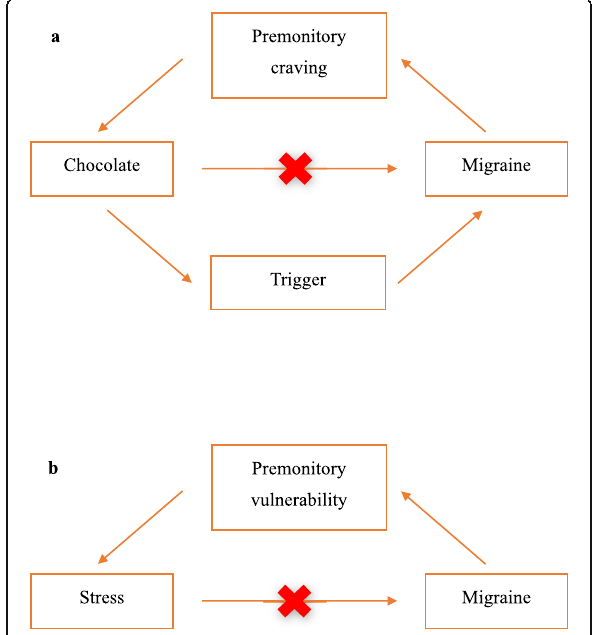
Fig. 2 Directed acyclic graphs illustrating the causality between attack risk factors and migraine attacks. a) Recall the experiment evaluating if chocolate is a migraine trigger, or rather the case of reverse causality where the premonitory craving of an impending migraine attack elicits chocolate consumption. b) Similarly, the manifestation of stress preictally may be the case of a state of increased vulnerability to